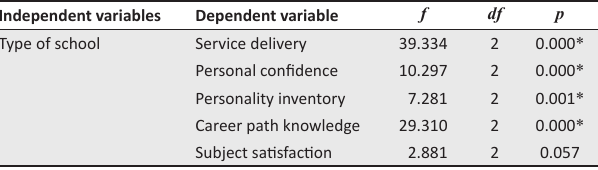
TABLE 4: Multivariate analysis of variance results for type of school and various aspects related to career guidance provided. Independent